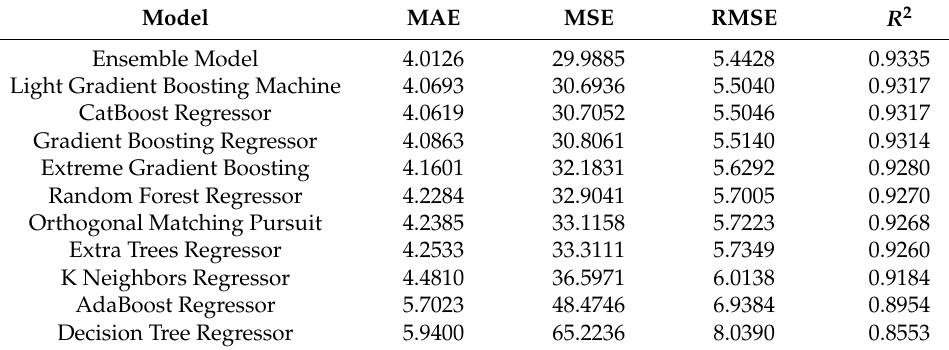
Table 2. Model performance for Relative Humidity